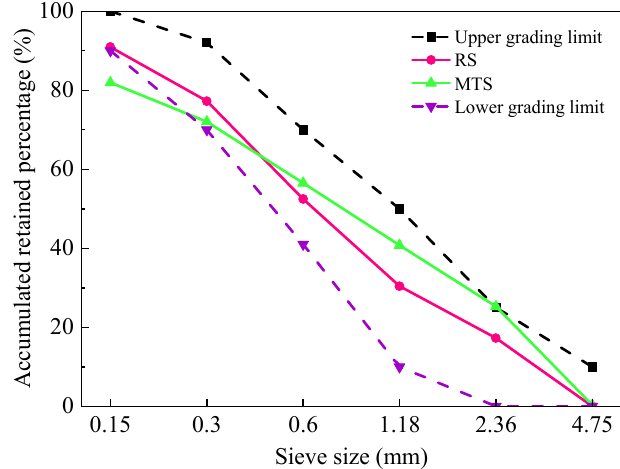
Figure 1. The gradation curves of RS and MTS.